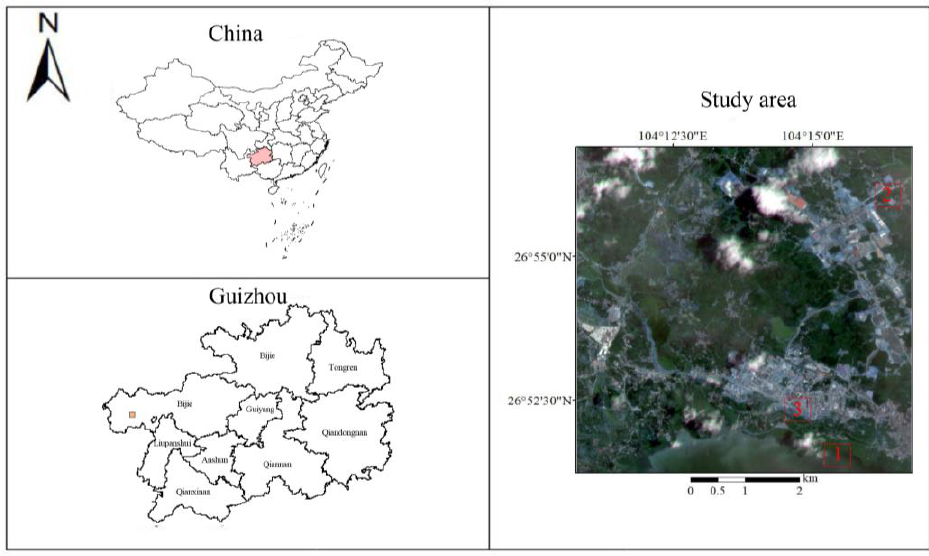
Figure 1. Location of the study region. (1) Land–water boundary area, (2) mountainous area, (3) urban area.